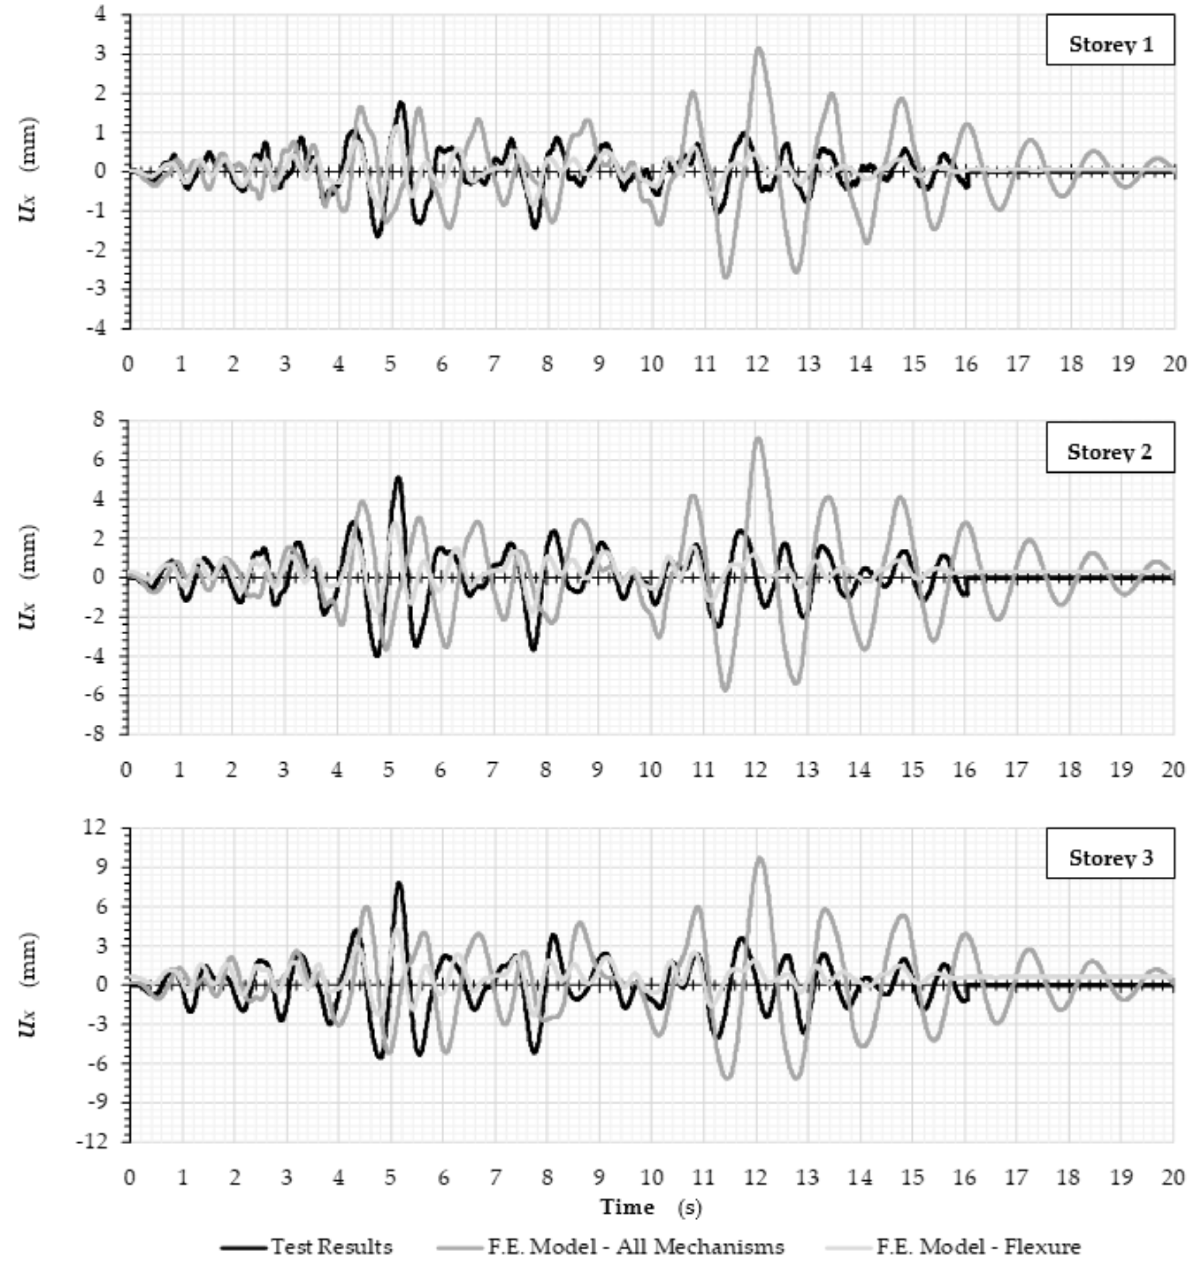
Figure 8. Comparison of the horizontal displacements in the X -plan direction measured at the SPEAR building during the s10 earthquake case and the corresponding response estimated from a dynamic analysis using two different FE building